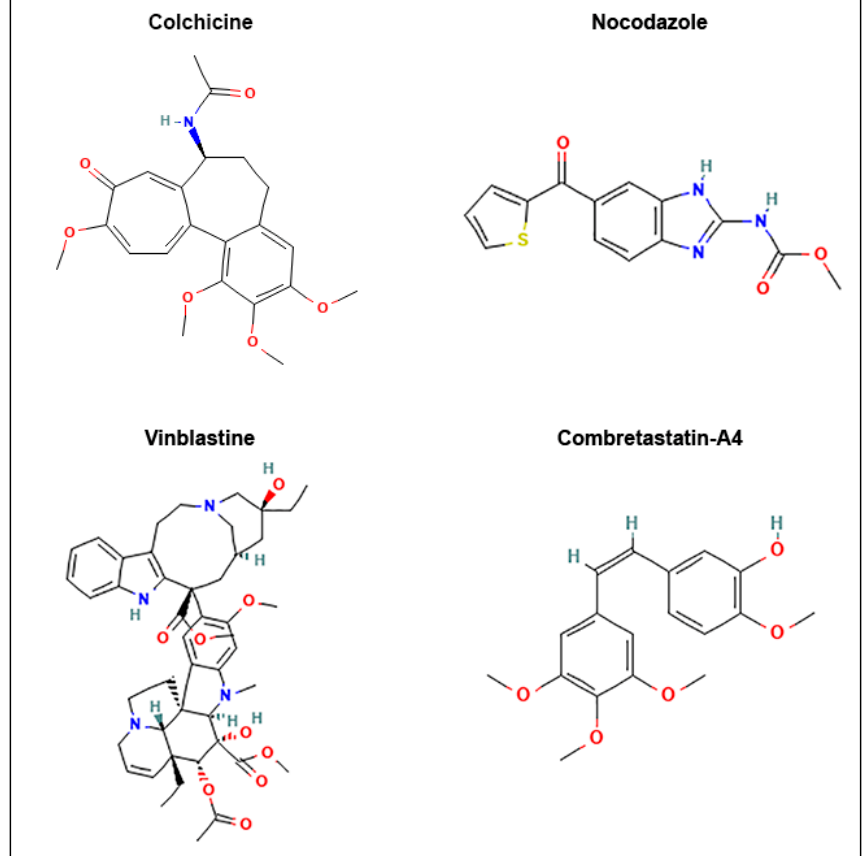
Figure 1. Chemical structure of the microtubule destabilizing agents used in this study.